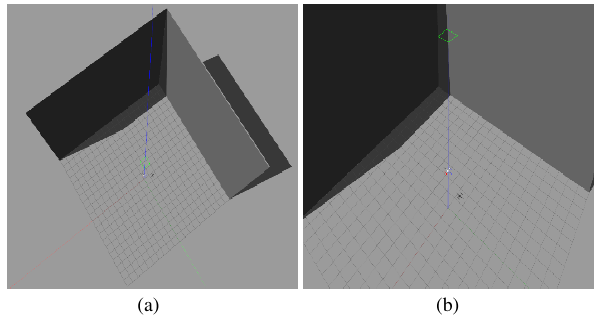
Figure 5. Experiment to measure the impact of the rotation on perpendicular and parallel walls